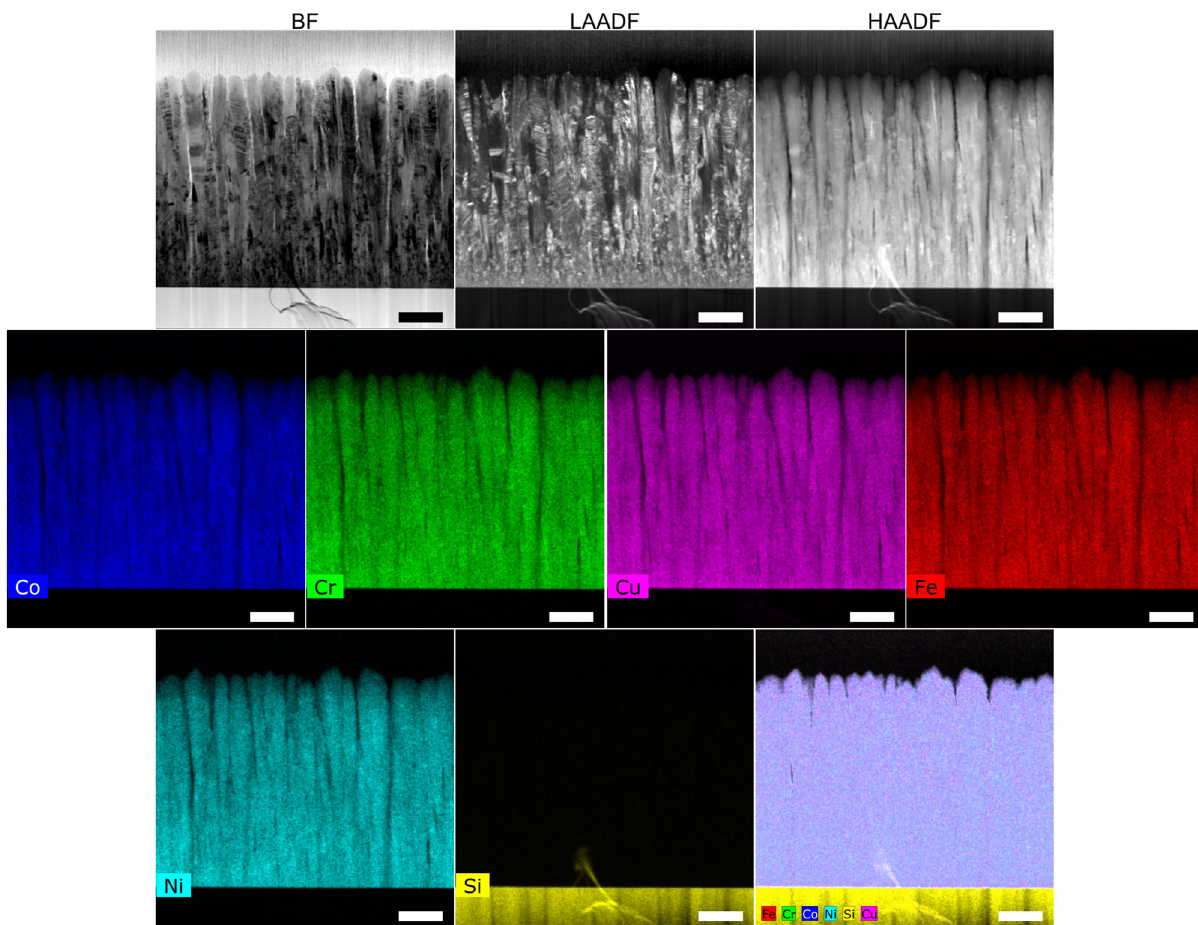
Fig. 1 As-grown HEA fi lm on Si is in solid-solution. STEM-BF, LAADF, and HAADF images and EDS maps of the as-grown CoCrCuFeNi fi lm on a Si substrate. The scale bar length in all images is 200